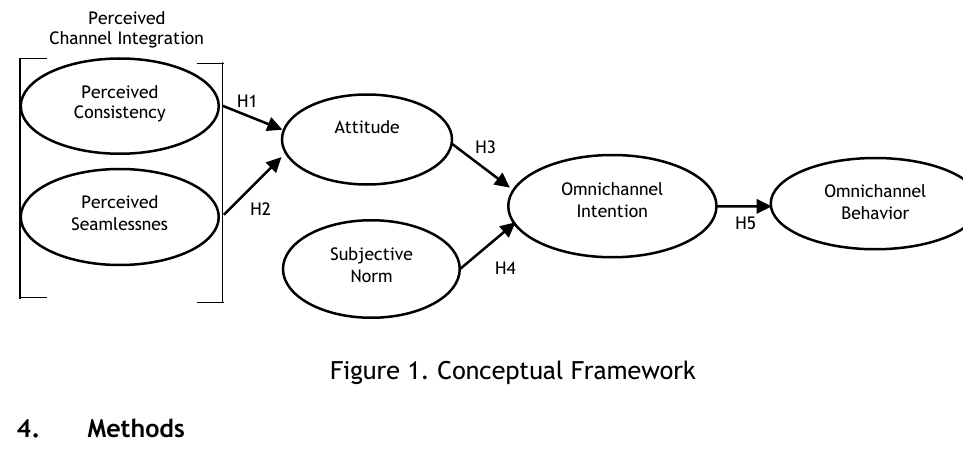
Figure 1. Conceptual